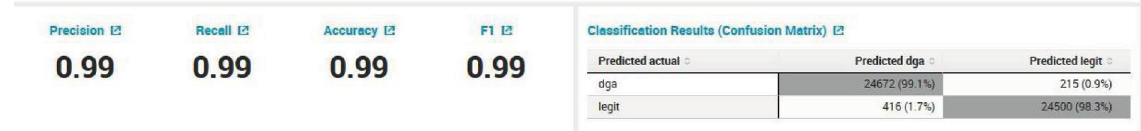
Figure 17: Evaluation of a random forest model with feature diagram using the principal component analysis feature.